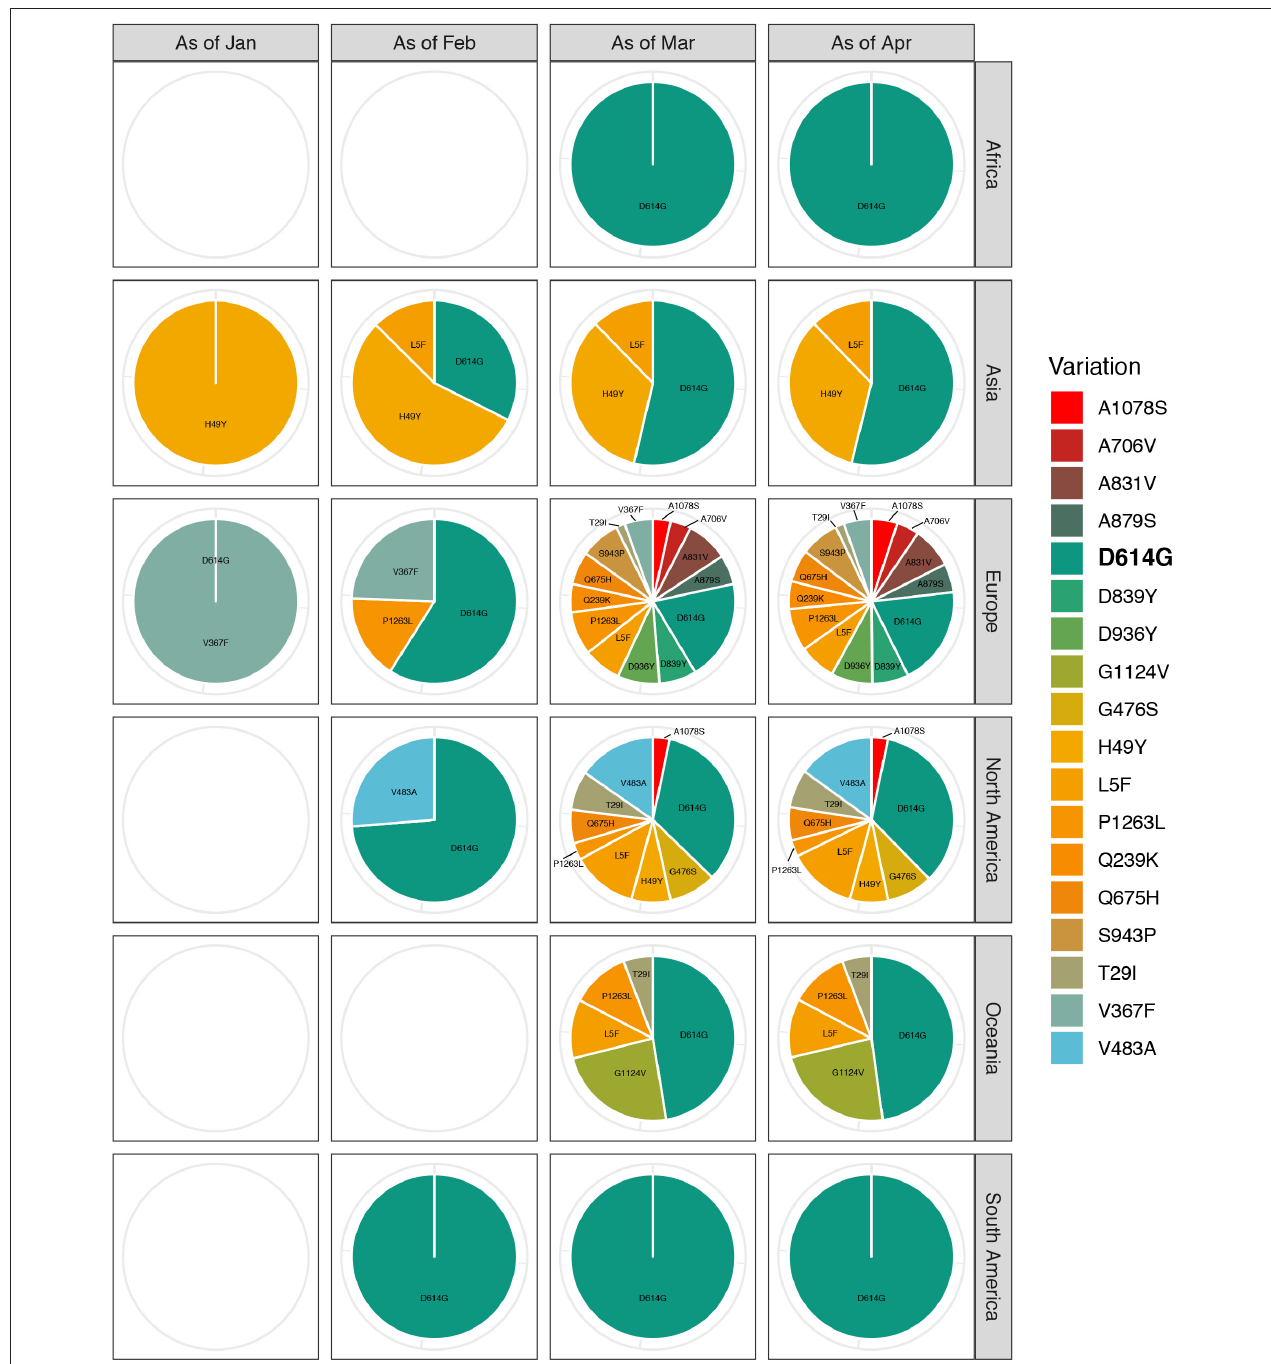
FIGURE 3 | Temporal and geographical distributions of sequences with relatively high-frequency amino acid variations on SARS-CoV-2 spike protein. All the relatively high-frequency sequences selected, containing amino acid variations, were classified according to the transmission course and region. Time refers to the collection date of the samples containing amino acid variations, which is divided into groups by month from December 2019 to April 2020. Each group is the total number of sequences up to the end of this month. Regions are classified by continent, including Africa, Asia, Europe, North America, South America, and Oceania. The highest frequency substitution site D614G widely distributes around the world and spreads through the whole transmission process. With the proceeding of transmission course, the variety of amino acid variations in each continent is increasing. Especially, Europe has the most kinds of amino acid variants, some of which are unique to the